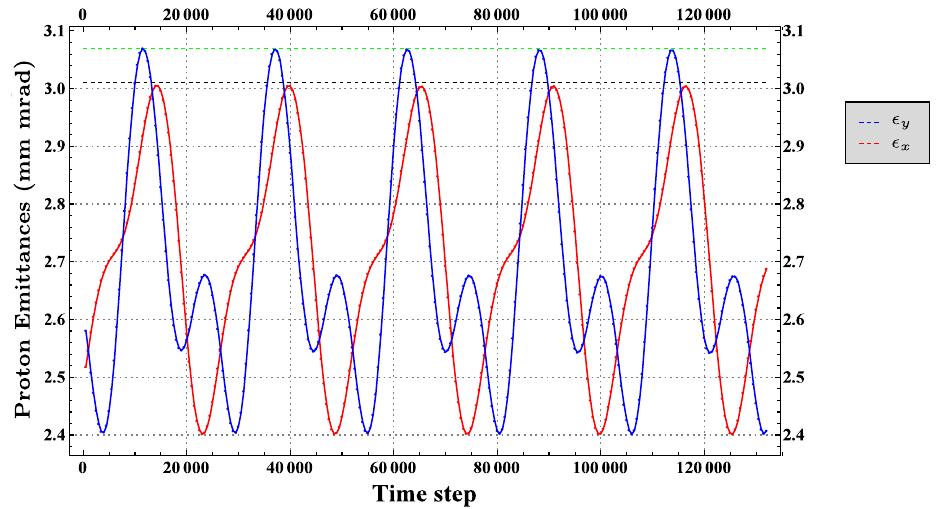
FIG. 16. The transverse emittance of the proton beam bunch of 1 cm radius cooled with an electron beam of the same radius, 1 T, and p 10 − 6 . The black and green dashed lines are reference lines for ϵ B =p z ¼ x;y z ¼